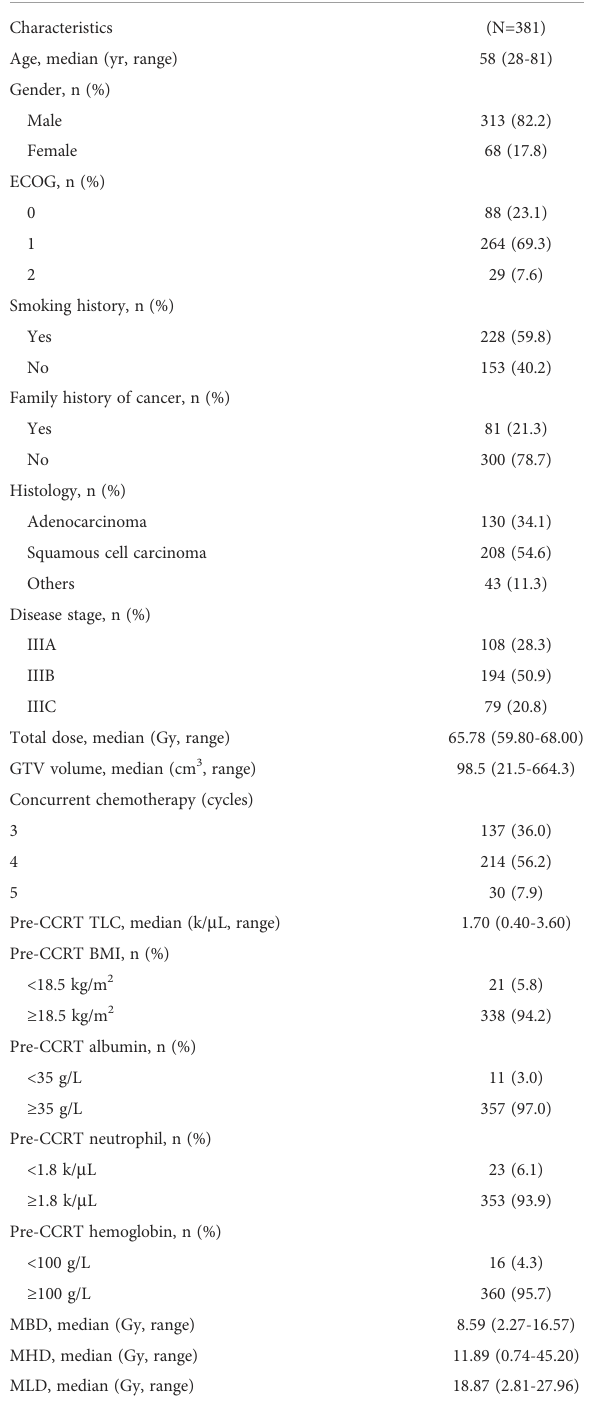
TABLE 1 Characteristics of patients